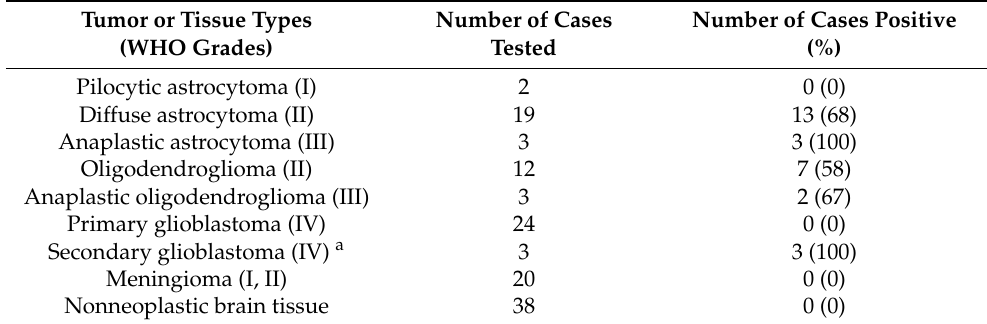
Table 2. Immunohistochemical testing results for IDH1 R132H with MRQ-67 in 124 cases of central nervous system tumors and surrounding brain tissue.